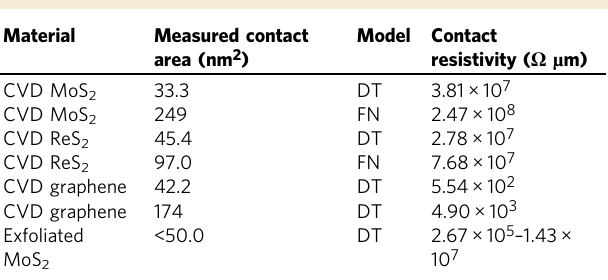
Fig. 4 Measured contact resistivity by in situ TEM. a Edge contact and b face contact. Table 1 Brief summary of all